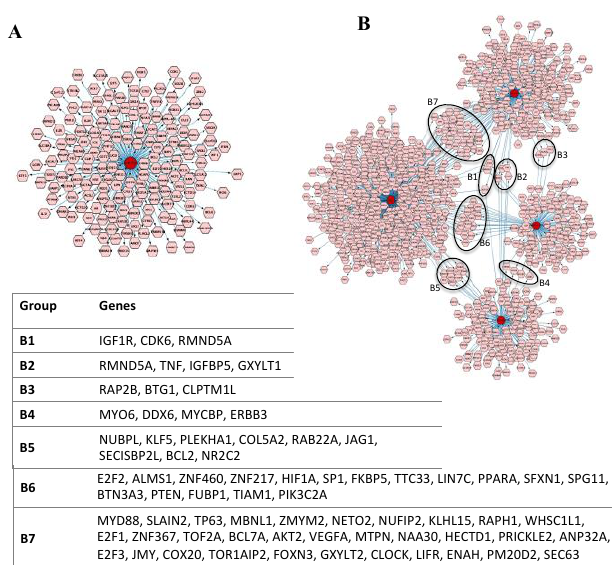
Figure 2. Network of target genes regulated by ( A ) hsa-miR-205 and ( B ) by a group of four miRNAs, including hsa-miR-21, hsa-miR-203, hsa-miR-22 and hsa-miR-143. Inset table indicates gene groupings regulated by at least (B1) three or (B2–B7) two miRNAs.